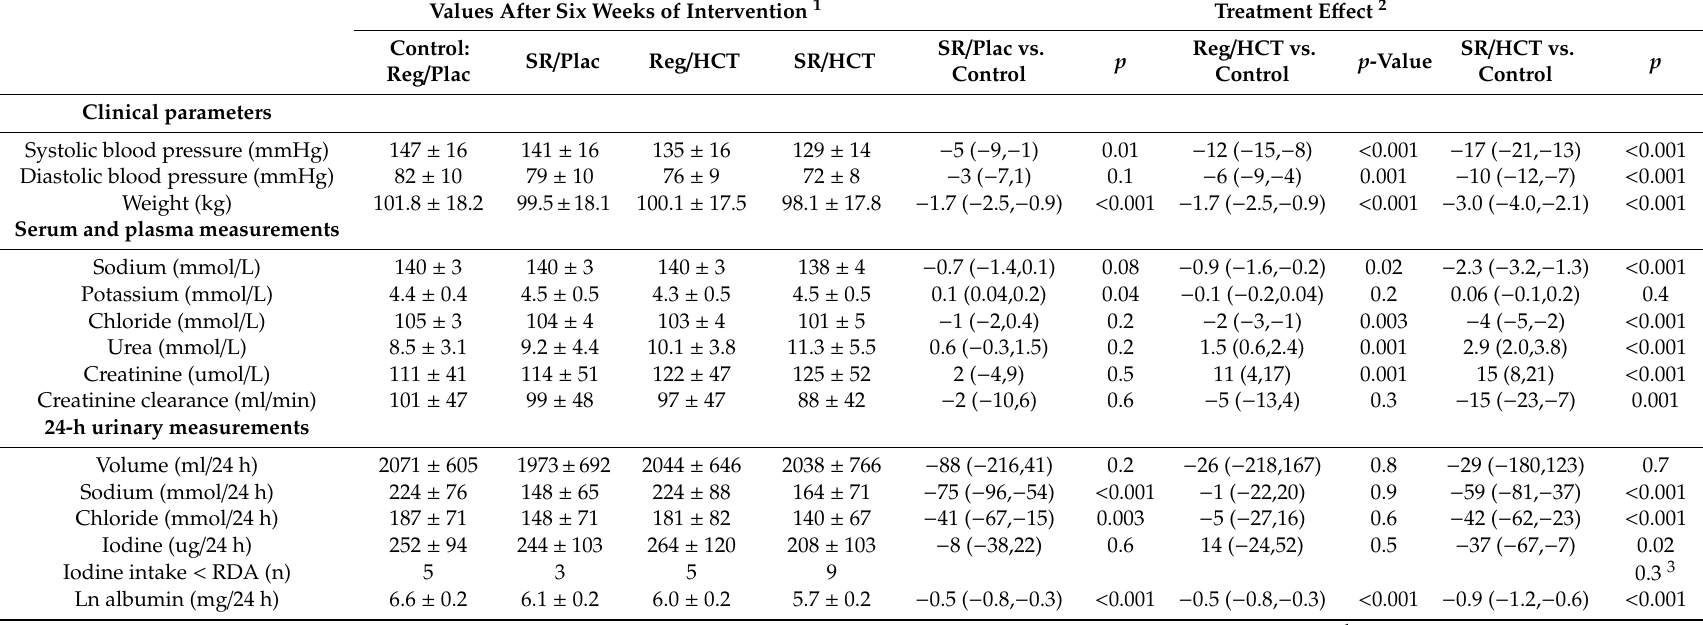
Table 3. E ff ects of sodium restriction, hydrochlorothiazide, and their combination on clinical parameters ( n = 45). Values After Six Weeks of Intervention